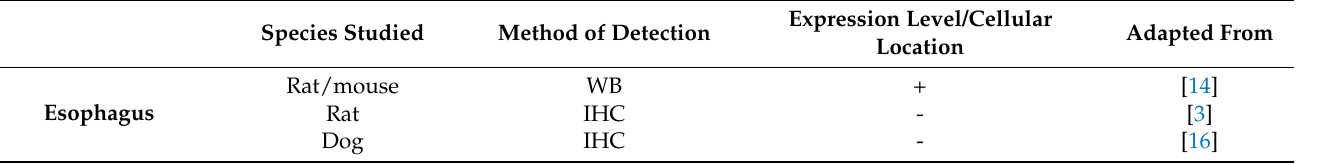
Table 1. The localization and level of expression of the nesfatin-1 protein in the mammalian gastroin- testinal